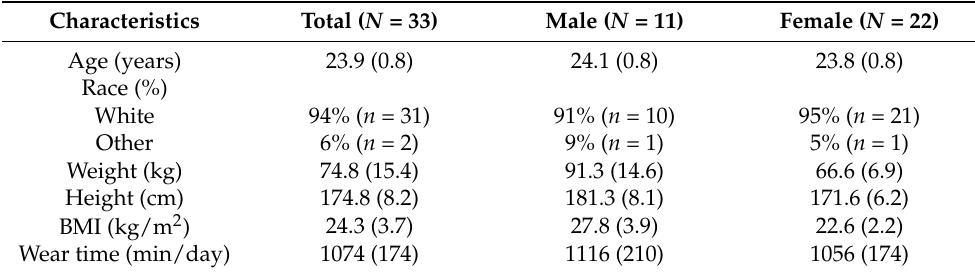
Table 1. Characteristics of study participant by gender, Mean (SD) or percent.